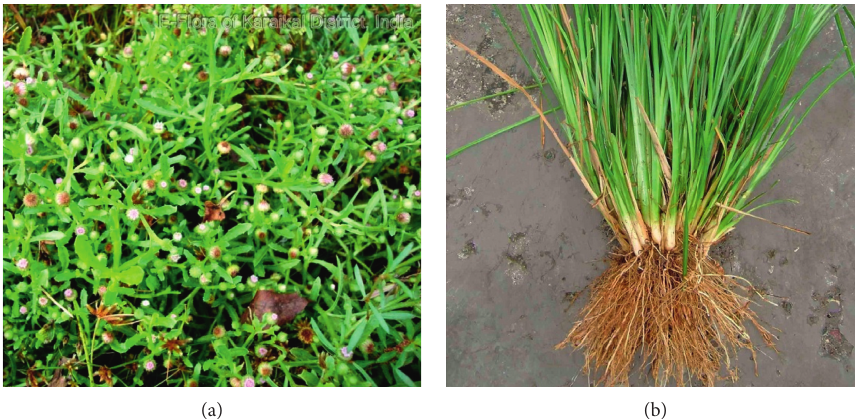
Figure 1: (a) Botanical name: Epaltes divaricata , local name: “Heen mudamahana,” family: Compositae; (b) botanical name: Vetiveria zizanioides , local name: “Sevendara,” family: